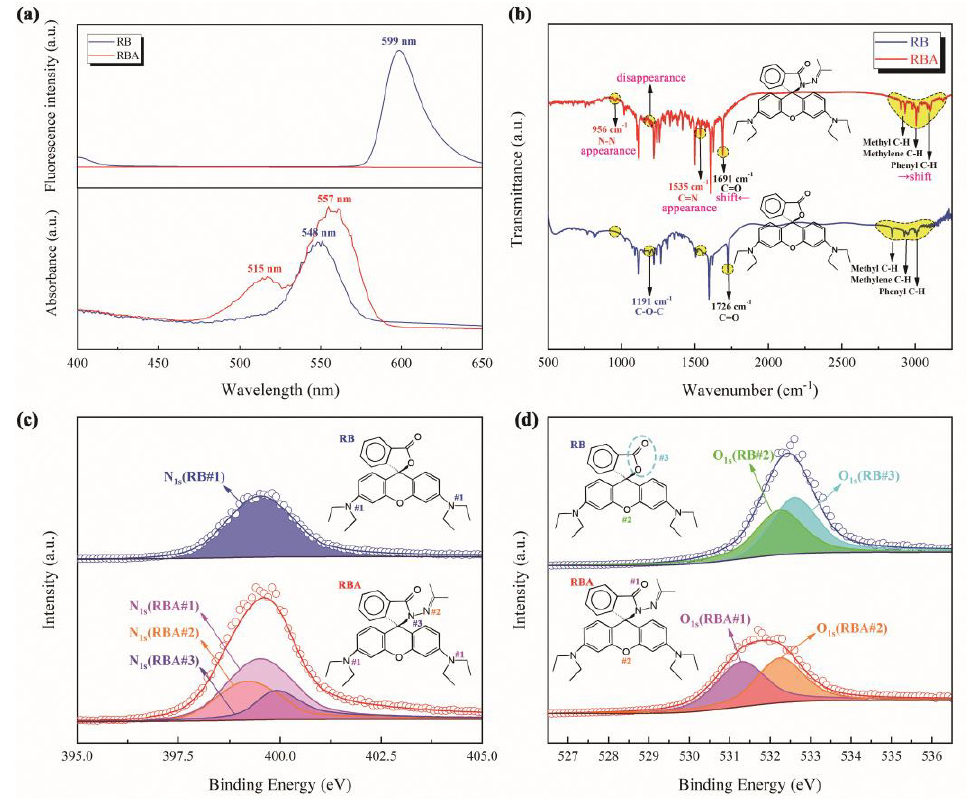
Figure 1. Structural analysis of RB and RBA, ( a ) UV-Vis absorption spectrum and fluorescence spectrum, ( b ) infrared spectrum, ( c ) XPS of N element and ( d ) XPS of O element.